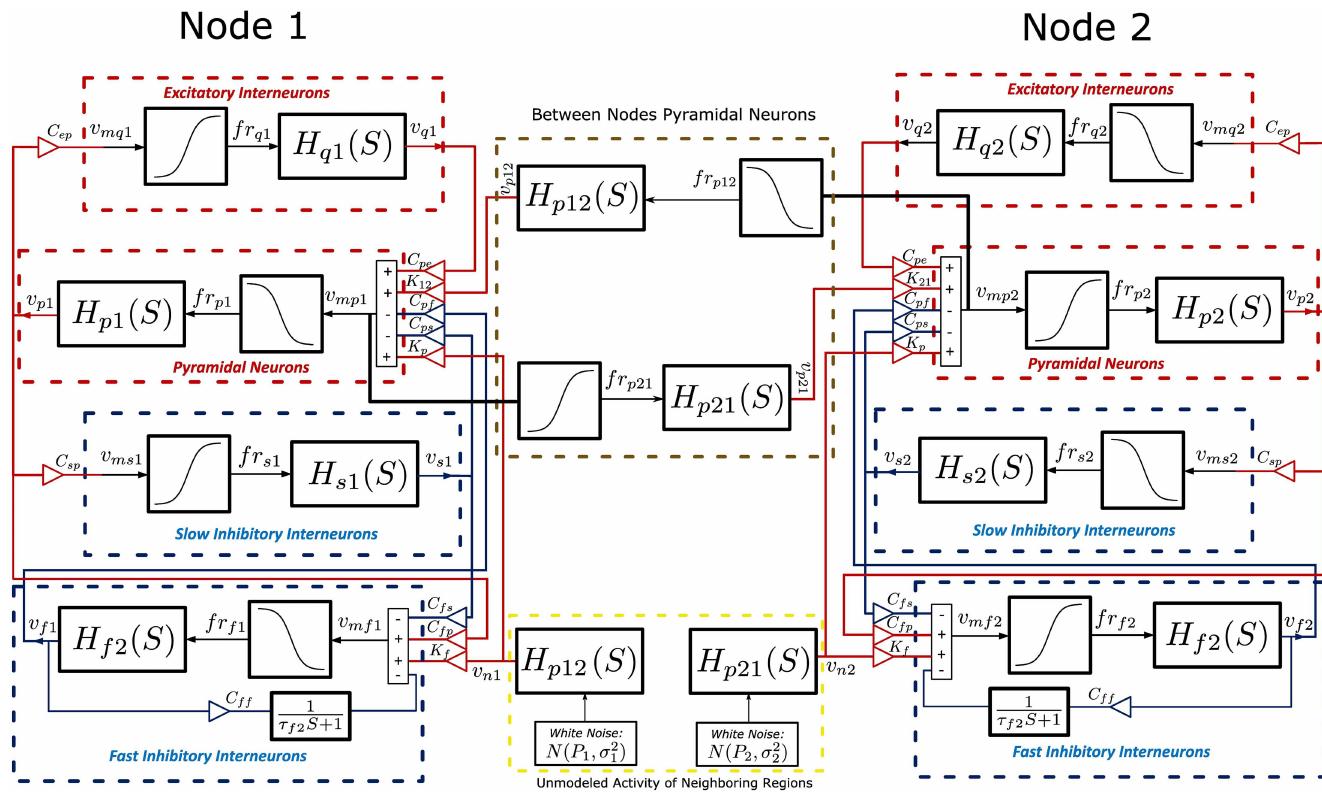
Fig 1. Schematic diagram of the proposed model. Each node is comprisedof four neuralpopulationunits: pyramidal neurons, excitatory interneurons, slow inhibtoryinterneurons and fast ihbitory internneurons. Each node is identicalto the NMM in [36]. The nodesare mutually connectedby the dynamics of the pyramidalneurons. Two independentGaussiannoise sources drive the NMM